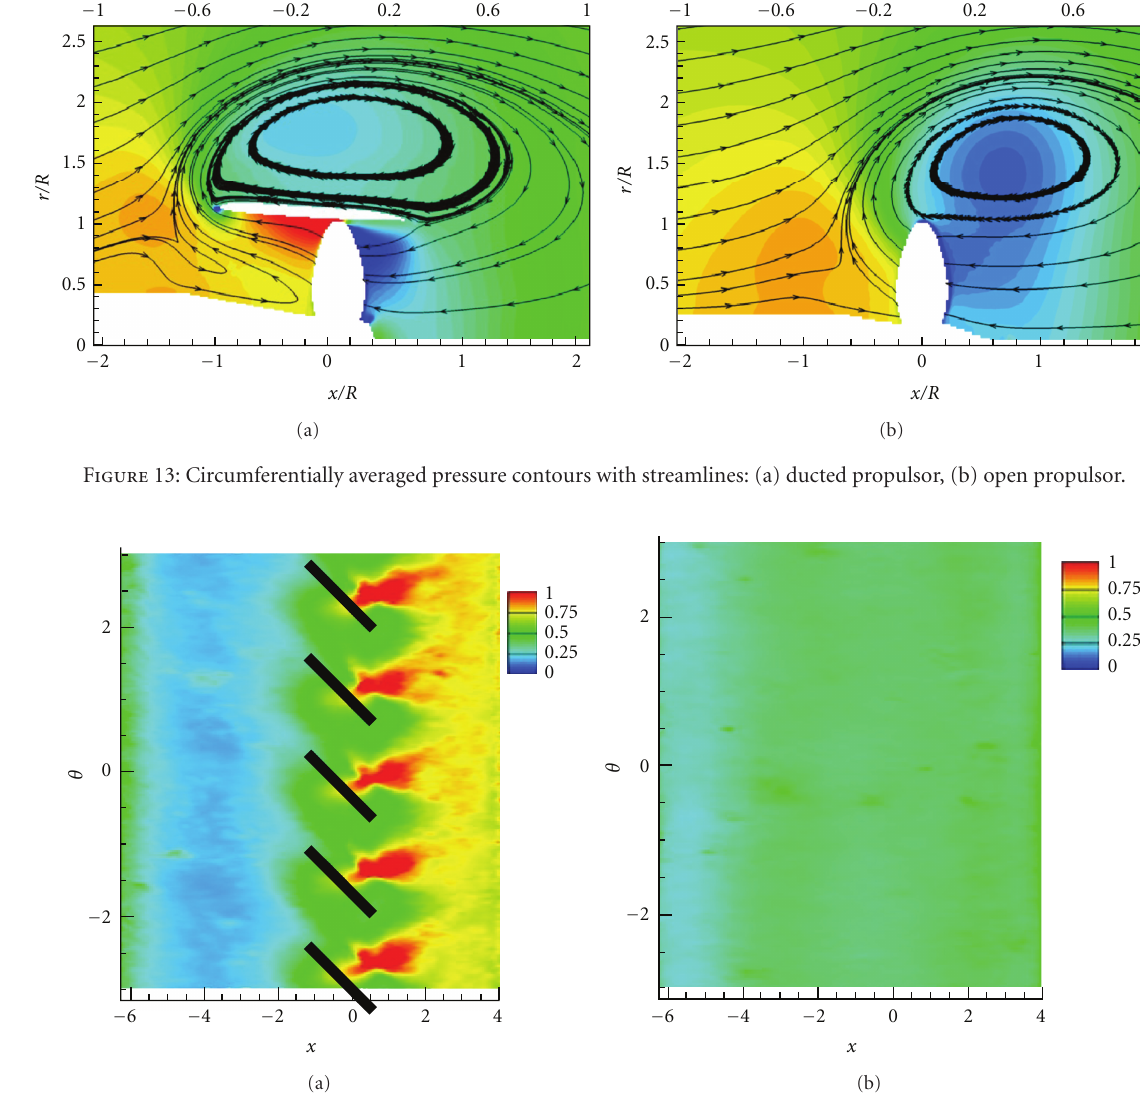
shows the computational grid for the ducted propulsor with the stator blades. In the figure, the red-colored line represents the sliding interface. The total number of the computational c.v.’s is approximately 27